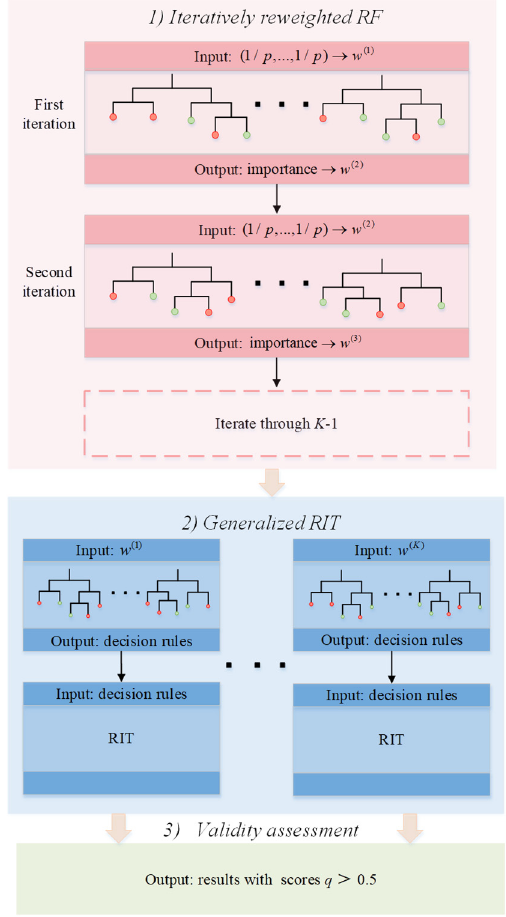
Figure 2. Basic flow chart of iterated random forest (IRF).